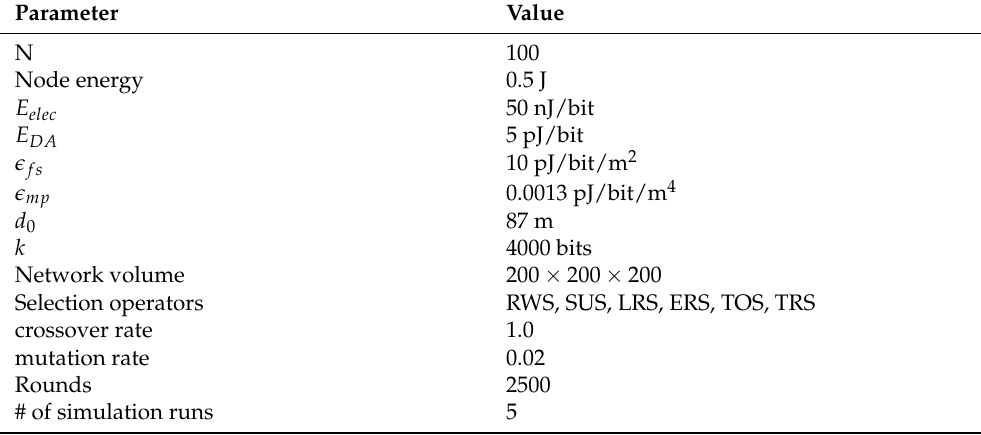
Table 3. Network parameters settings.